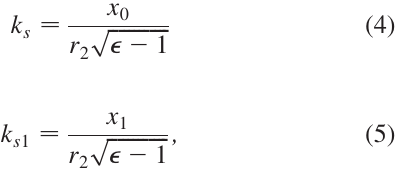
FIG. 1. (Color) Amplitudes ( A and k s ) as a function of the parameter (cid:3) ¼ r 1 2 : 5 mm .